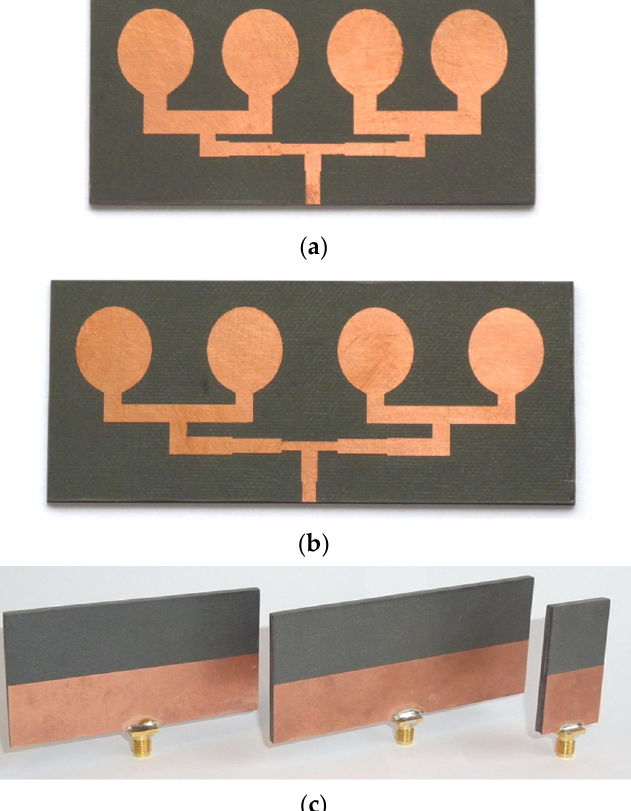
Figure 3. Photographs of proposed antennas: ( a ) Central metallic layer of shorter variant of four-element antenna array; ( b ) Central metallic layer of longer variant of four-element antenna array; ( c ) Fabricated antennas.